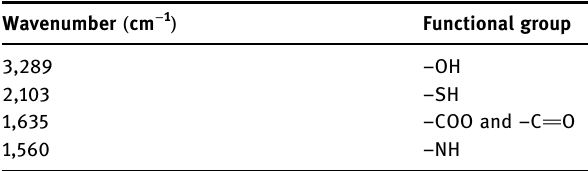
Table 2: IR absorption bands and possible corresponding